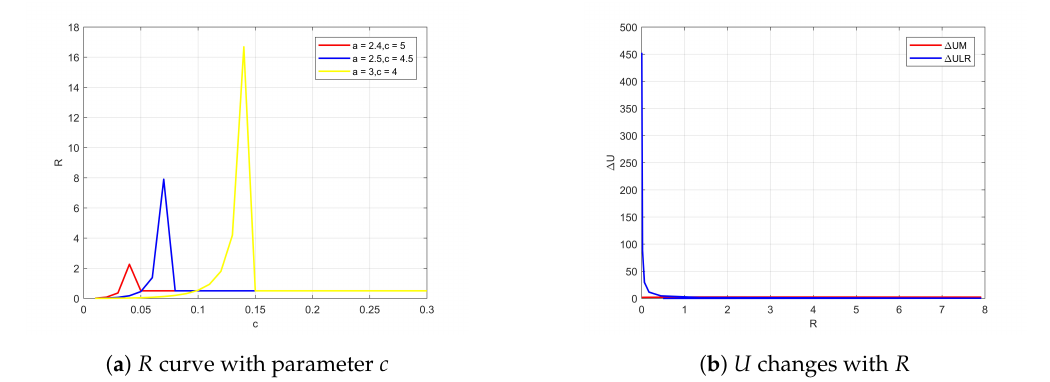
Figure 7. R curve with parameter c and U changes with R .